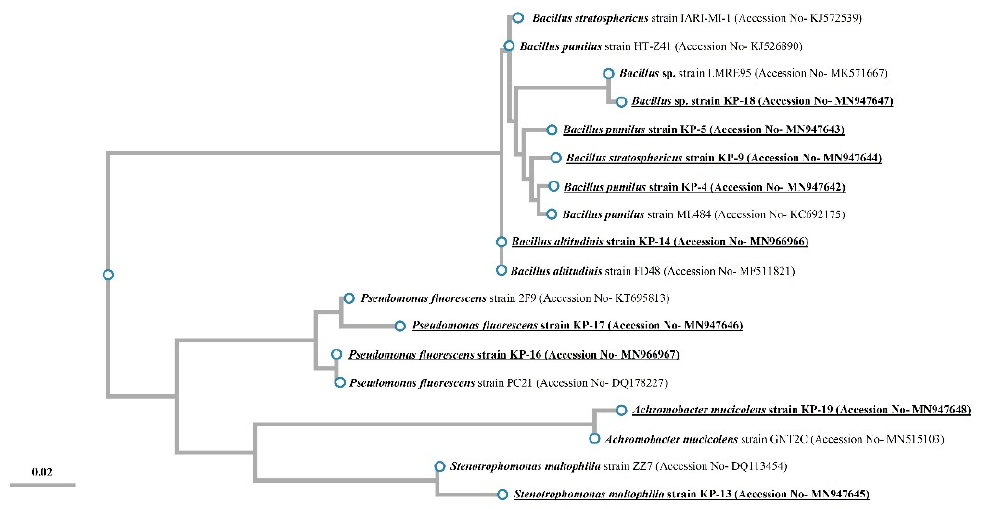
Figure 1. Phylogenetic trees based on 16S rRNA gene sequences showing clustering of all 9 isolates with their nearest phylogenetic relatives. Phylogenetic trees were constructed by the neighbor-joining method. The bar represents 0.02 substitutions per alignment position. Table 1. Identification of isolated strains based on their 16S rDNA sequences and NCBI GenBank database.